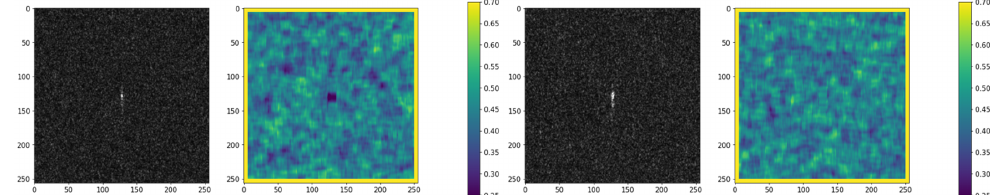
Figure 8. Example of IE calculated for ship target ( left ) and ambiguity ( right ) for a SAOCOM product. (Product ID: S 1 A _ OPER _ SAR _ EOSSP __ CORE _ L 1 A _ OLVF _20210122 T